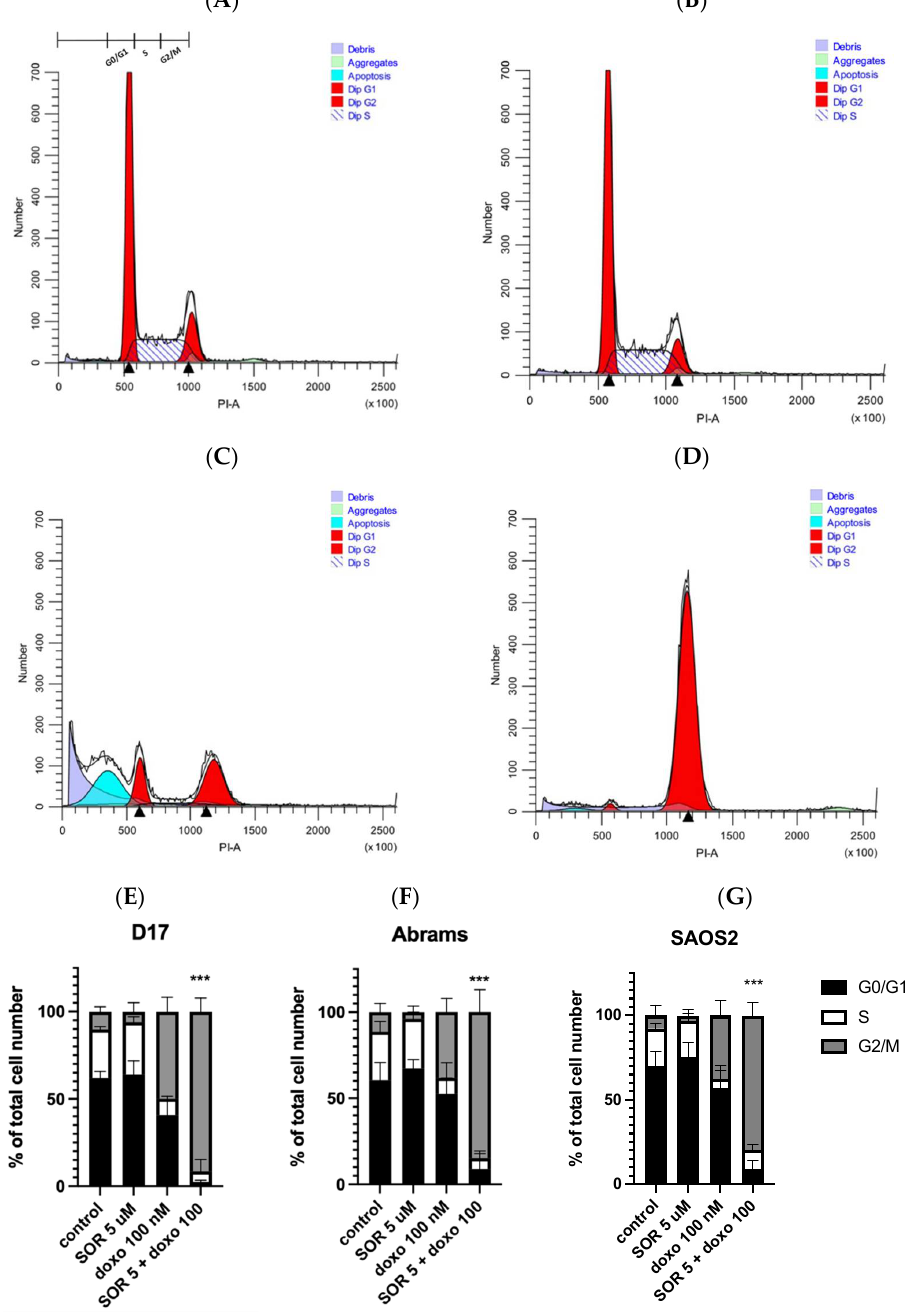
Figure 5. The combination of sorafenib and doxorubicin caused inhibition of cell cycle progression, resulting in G2/M arrest in D17 cells. Cell cycle distribution of D17 OSA cells treated with either ( A ) DMSO (control), ( B ) sorafenib 5 μM, ( C ) doxorubicin 100 nM, or ( D ) both sorafenib 5 μM plus dox- orubicin 100 nM for 24 h. Representative flow histograms demonstrate changes in the cell cycle progression on canine OSA D17 cell line. The combination of sorafenib and doxorubicin resulted in a cell arrest at the G2/M phase. Representative cell cycle distribution graphs show G2/M cell arrest in ( E ) D17, ( F ) Abrams and human OSA, and ( G ) SAOS2 cell lines. ***: p < 0.001 for G2/M arrest compared to the combined treatment (5 μM sorafenib and 100 nM doxorubicin) as determined by one-way ANOVA with Dunnett’s multiple comparison test.